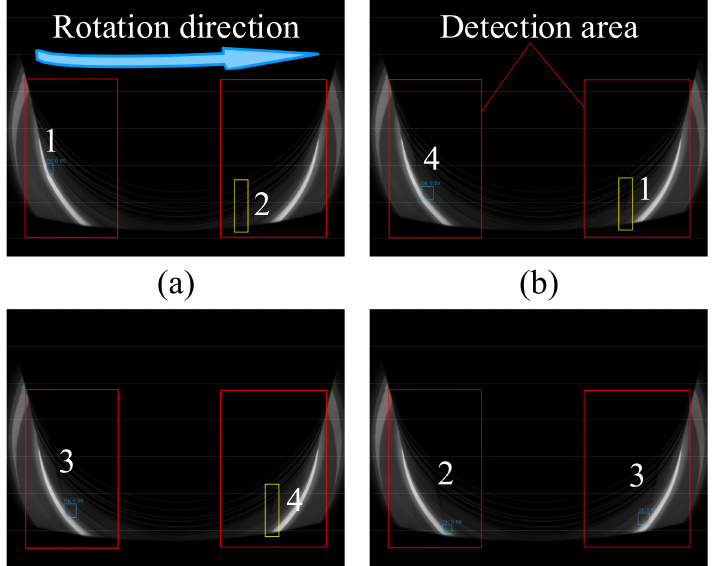
Figure 10. Inference results of the tracking process. ( a ) the first 1 / 4 cycle, ( b – d ) the next three 1 / 4 cycles, the habit lines marked with yellow box are not detected due to